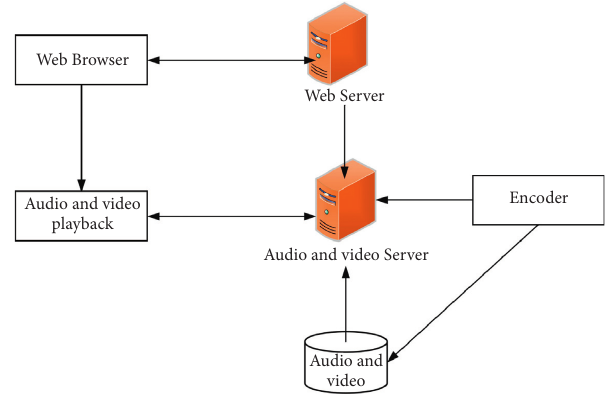
Figure 7: Platform